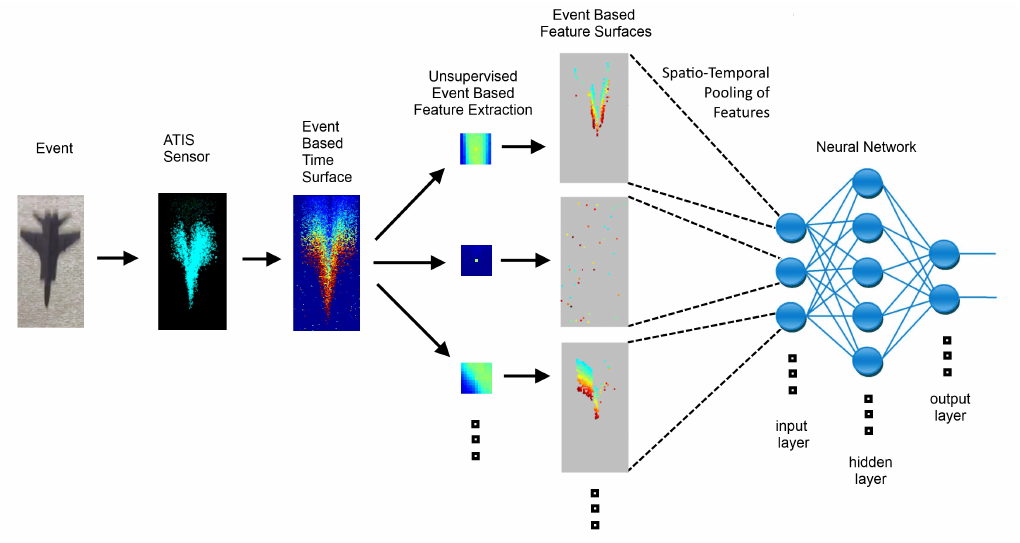
Figure 7. Feature Extraction with Adaptive Selection Thresholds (FEAST) Features for the Plane Dropping dataset. The 25 spatiotemporal features produced when using the FEAST algorithm on the Plane Dropping dataset. Note that the plane dropping demonstration only uses the ON polarity due to the low Signal-to-Noise-Ratio (SNR) in the OFF events. Specific features can be seen coding for the leading edge of the airplane nosecone and for the wings. There are multiple features that code for noise events, as can be seen by several near-empty features. The colors used to represent the features are indicative of time, as these features represent complex spatiotemporal